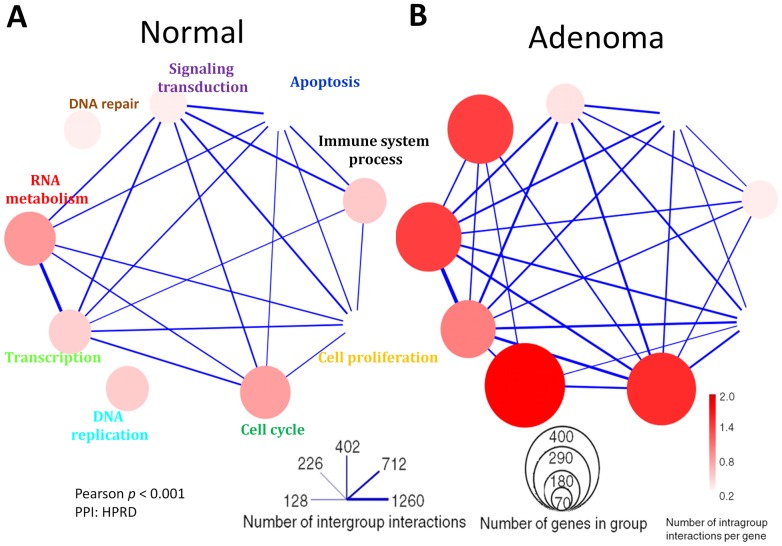
Function-function networks for colorectal adenoma.Condition specific function-function networks (FFNs) were generated from gene-gene networks (GGINs), shown in Figure S2, by reduction. Nodes in an FFN are functional modules (FMs), which are gene sets in the corresponding GGIN forming over-represented Gene Ontology terms. FMs containing less than 70 genes are not shown. The diameter of a node scales with the logarithm of the number of genes in the node. The color shade of a node indicates the number of intra-node gene-gene interactions per gene. The thickness of the edge indicates the number of inter-node gene-gene interactions.